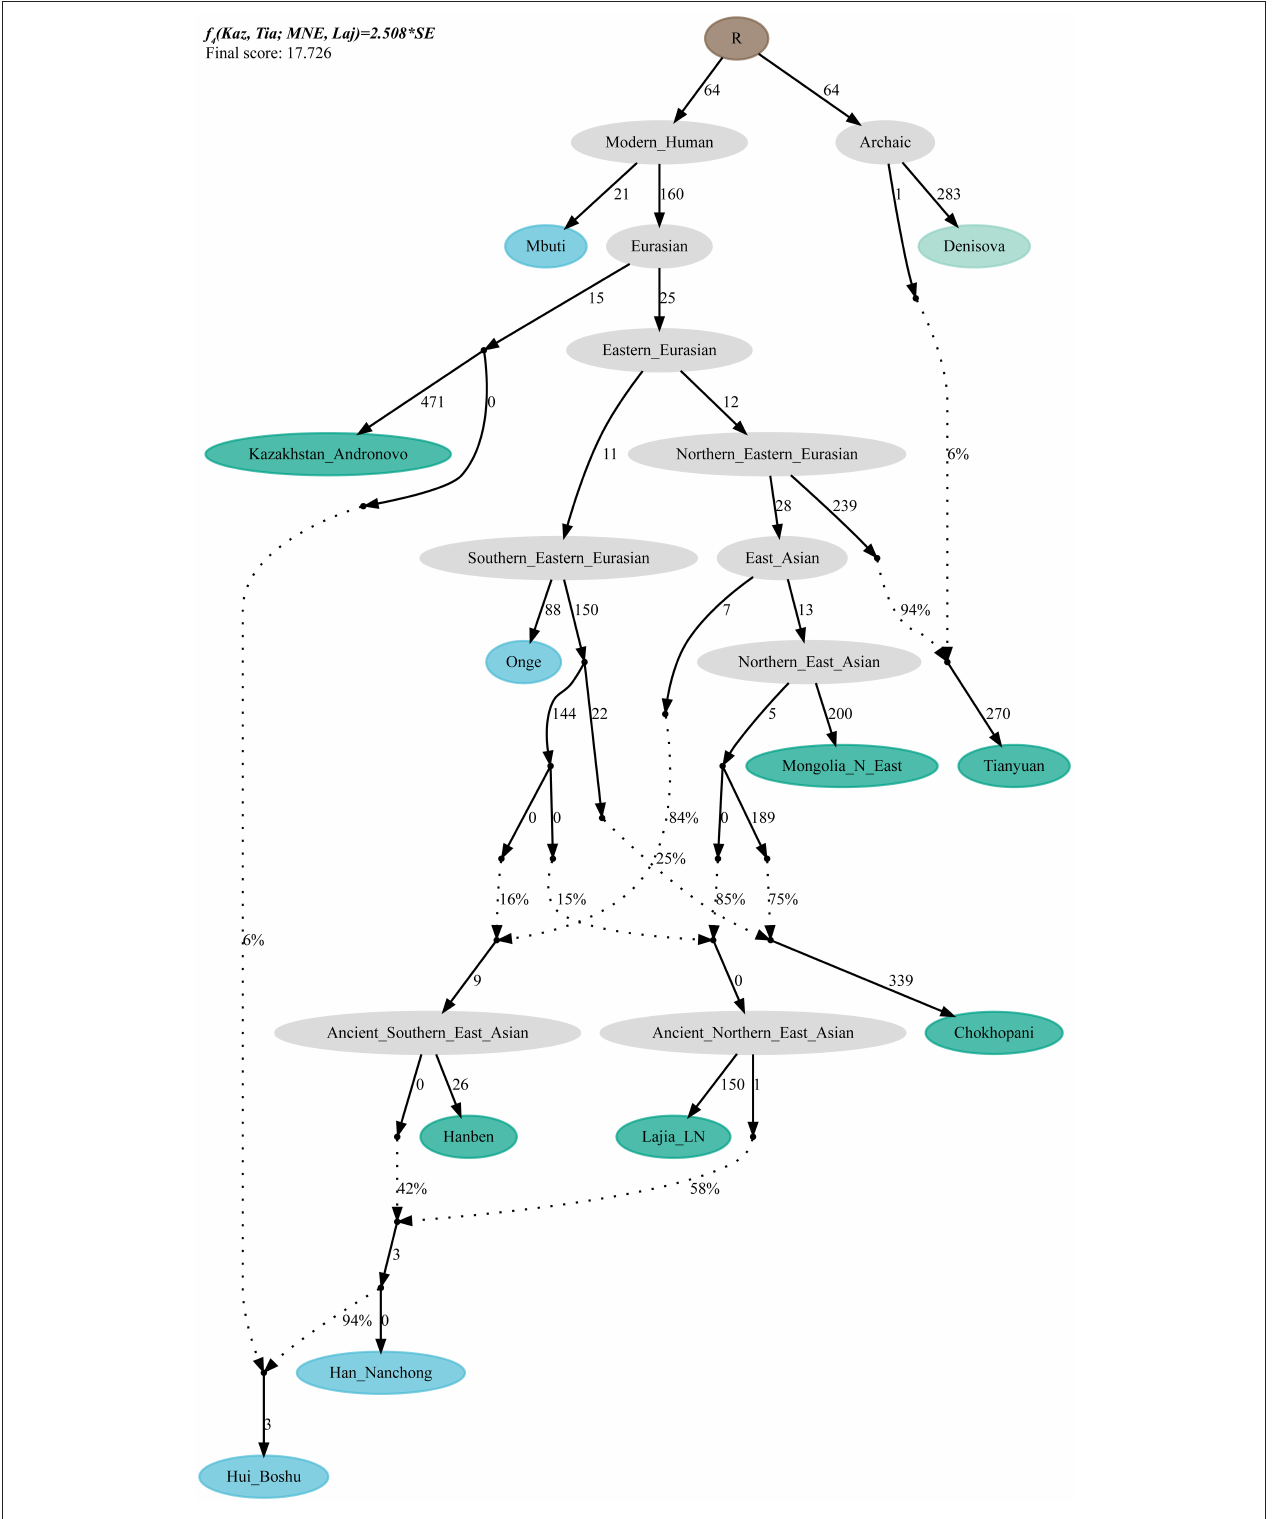
FIGURE 6 | QpGraph-based admixture graph. QpGraph -based phylogeny showed the western Eurasian gene flow event in Boshu Hui. Branch length was marked with the f 2 shared drift distance (1,000 times). Admixture events were denoted as dotted line. Admixture proportion was marked along the dotted line. Here, we used Hungary Scythian as the western